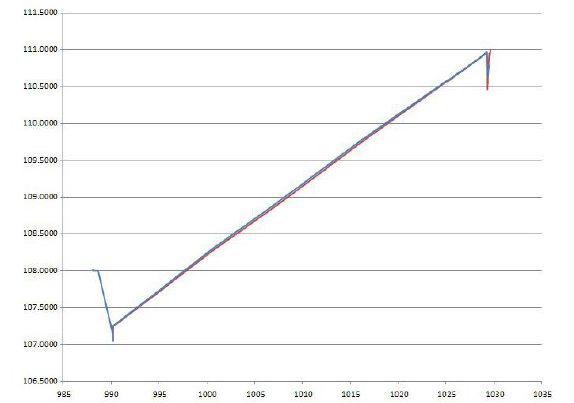
Figure 05. Analytical Processing: displacement plot